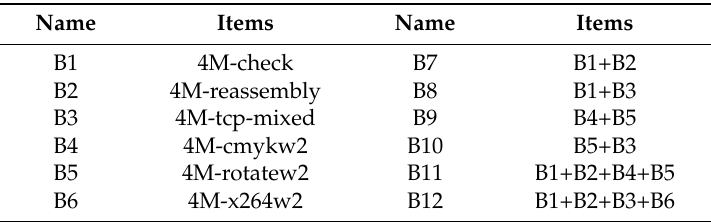
Table 6. EEMBC mix-mode workloads.